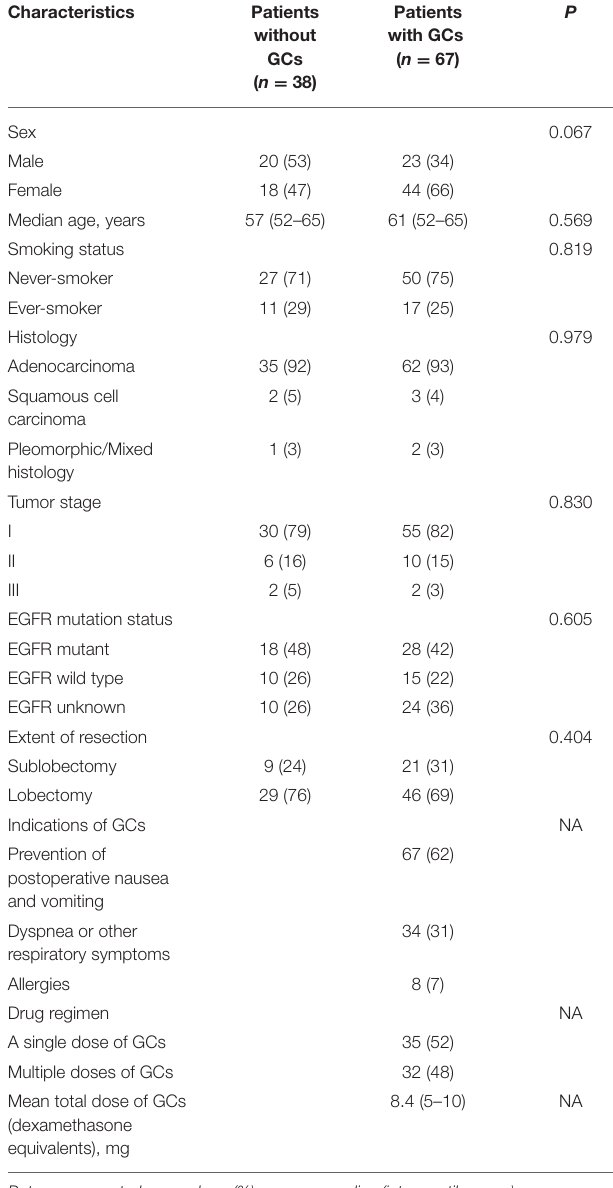
TABLE 1 | Baseline characteristics of